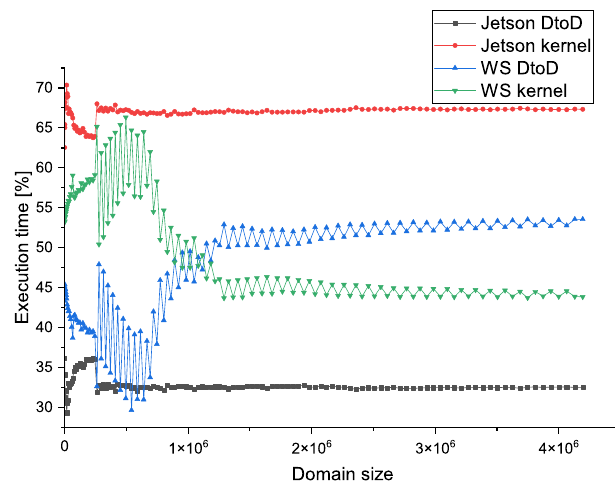
Figure 10. Relative execution times of GPU activities.